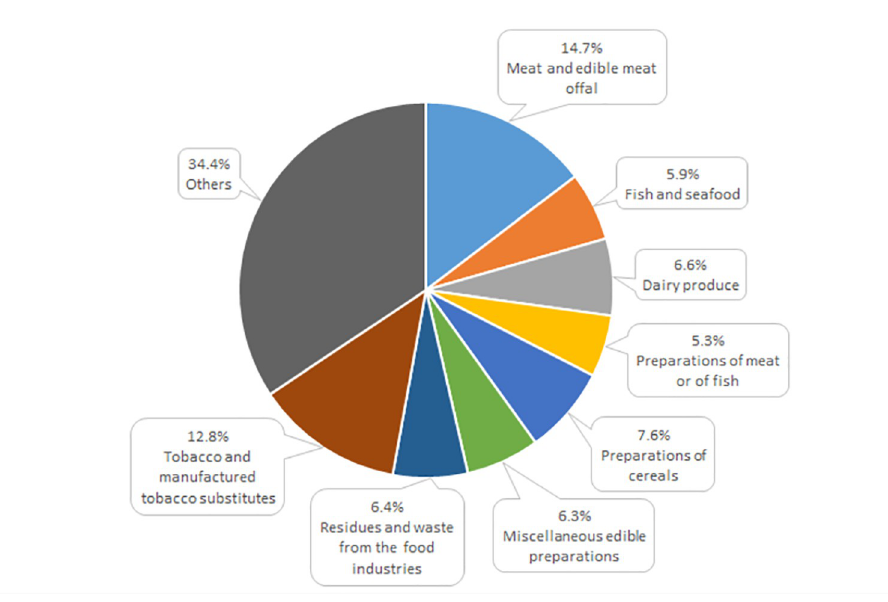
Fig 4. Commodity structure of Poland’s export of agri-food products to the other EU countries in 2021 (%). Source: [13], the authors’ elaboration.